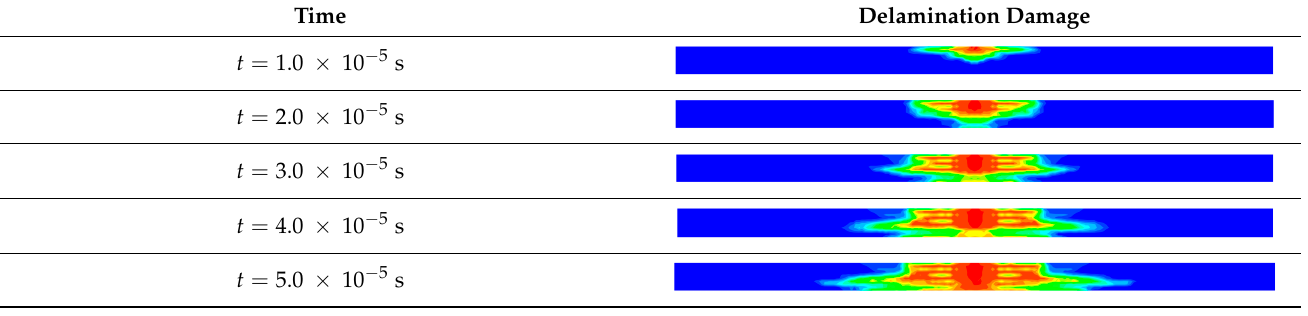
Table 4. Delamination damage of the cross-section. Time